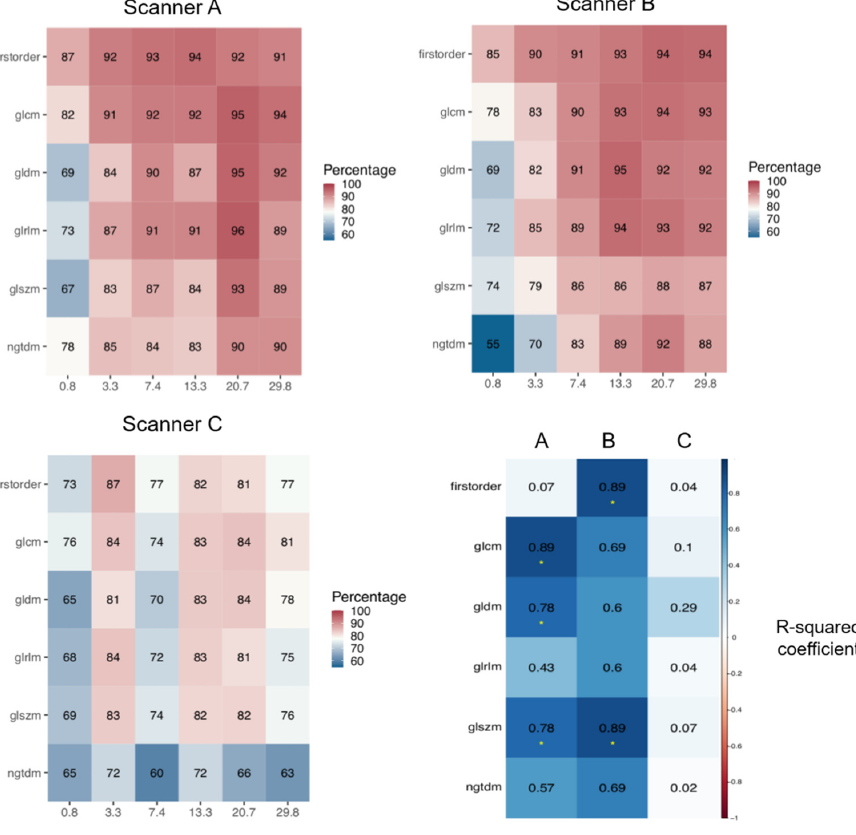
Figure 4. Overall percentage of features discriminative at different volumes for each feature class in scanners A (top left), B (top right), and C (bottom left). At bottom right, coefficient of determination, R-squared, of the percentage of discriminative features explained by the volume for each scanner.